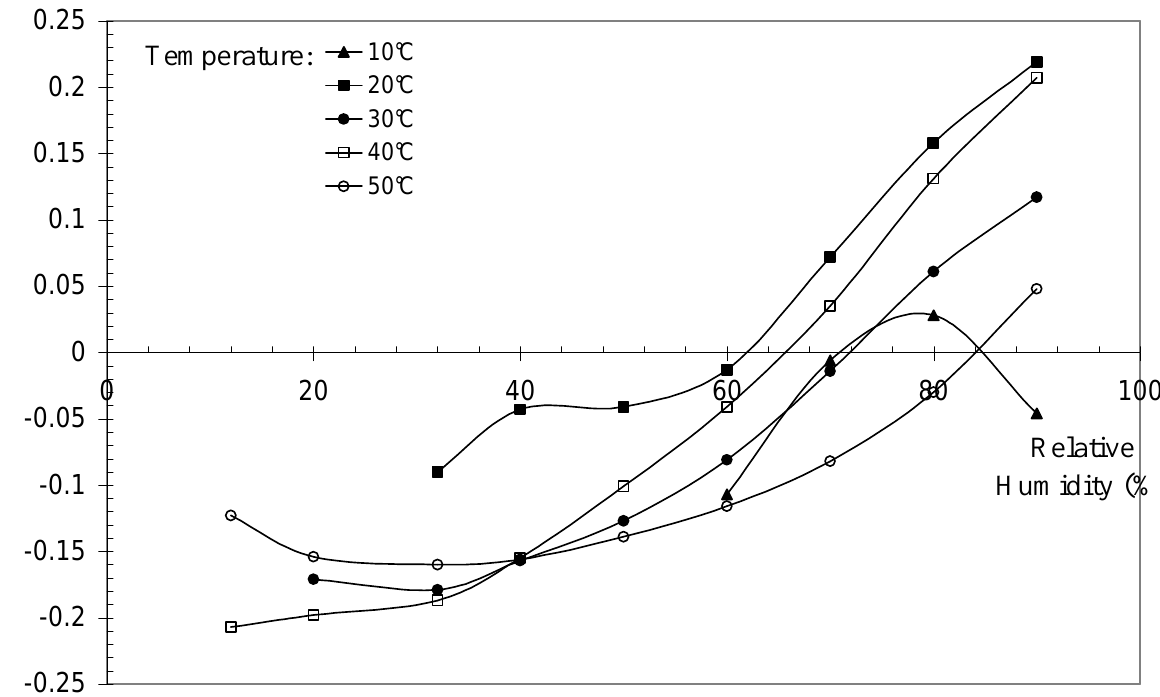
Figure 10. Normalized relative resistance vs. relative humidity in isothermal